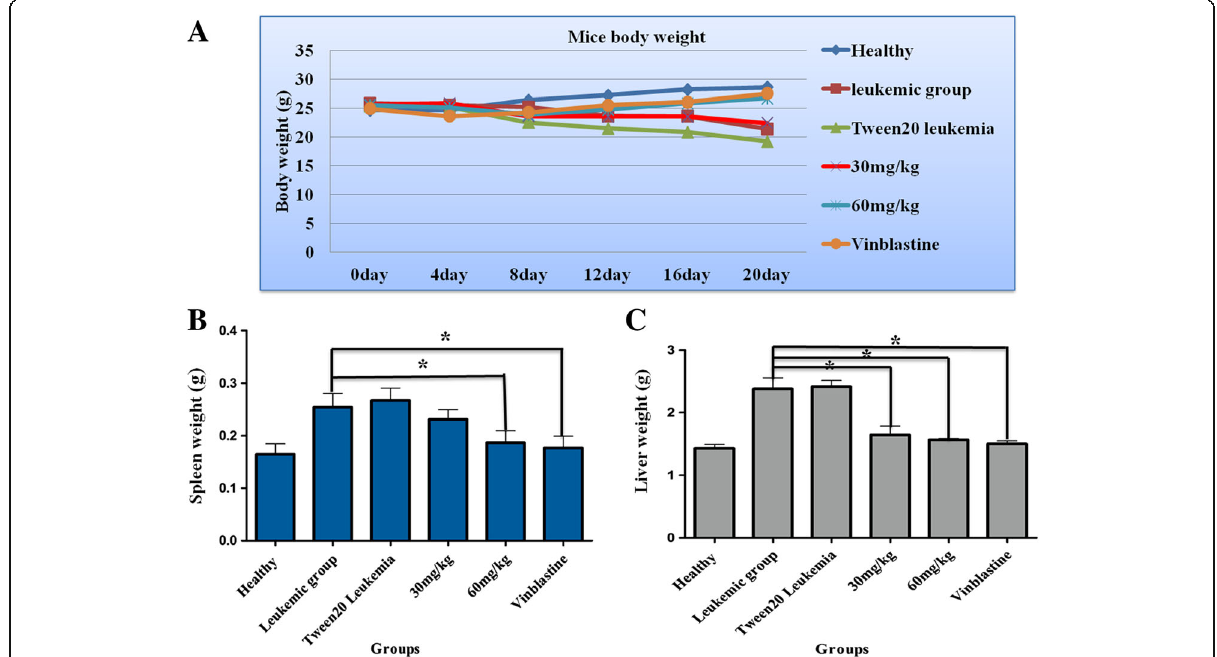
Fig. 11 a Monitoring of body weight of the different groups for 3 weeks. b Spleen weights of all groups ( c ) Liver weights of all groups after 3 weeks